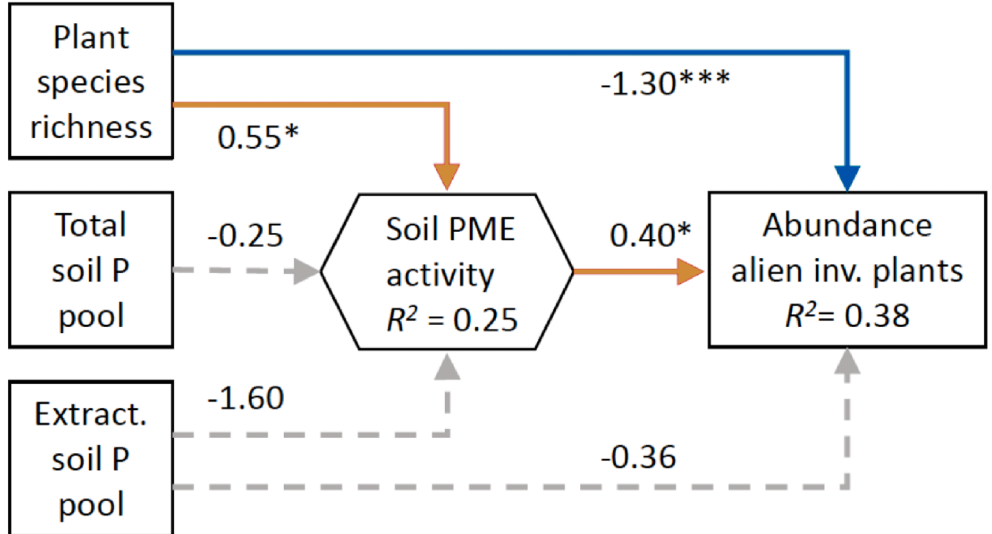
Figure 1. Structural equation model (SEM) showing direct (blue arrow) and indirect (orange arrow) connections between plant species richness and the abundance of alien plants in the Cerrado. The possible connection between species richness and soil phosphatase activity (PME) follows results obtained in the Jena Biodiversity Experiment 29 . Also connections between the total soil P and soil extractable P (Mehlich) pools on soil phosphatase activity, as well as a direct connection between soil extractable P and abundance of alien plants are included in the SEM. Plant variables are recorded on 334-m 2 plots using the Braun–Blanquet scale, soil parameters are from the top 10-cm soil. Numbers associated with paths between variables are path coefficients presented as standardized values (scaled by the standard deviations of the variables). Solid arrows show significant connections (* p < 0.05, *** p < 0.001), dashed arrows show insignificant connections ( p > 0.05). Goodness of fit of the SEM: p χ 2 = 0.452 (a good model fit indicating that the fit is clearly not significantly different from the theoretical